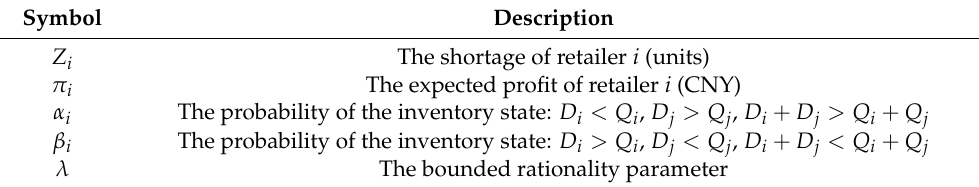
Table 1. Cont . Symbol Description Z i The shortage of retailer i (units) π i The expected profit of retailer i (CNY) α i The probability of the inventory state: D i < Q i , D j > Q j , D i + D j > Q i + Q j β i λ The bounded rationality